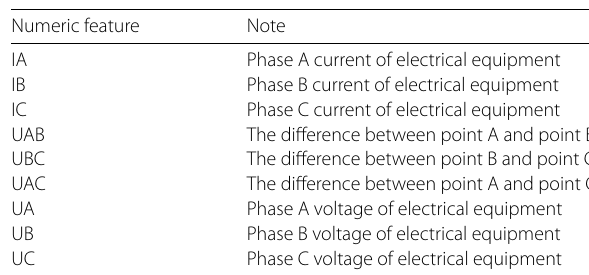
Table 1 The original feature relevant to